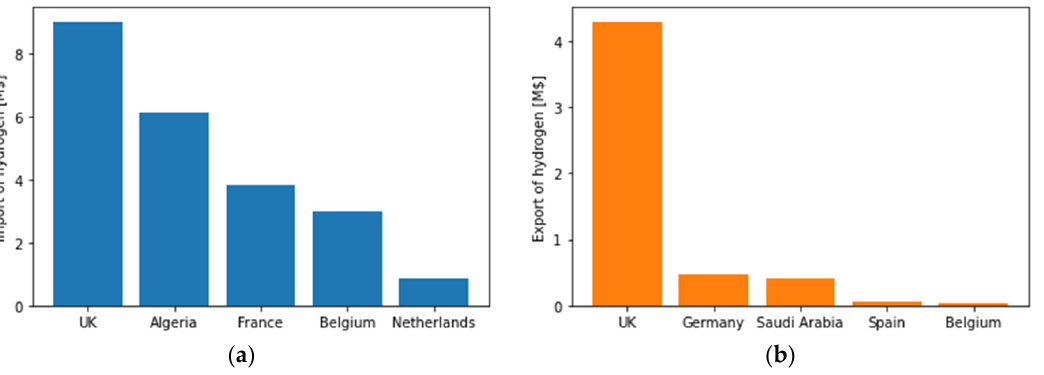
Figure 3. ( a ) Ireland imports of hydrogen from other countries, and ( b ) Ireland exports of hydrogen to other countries.